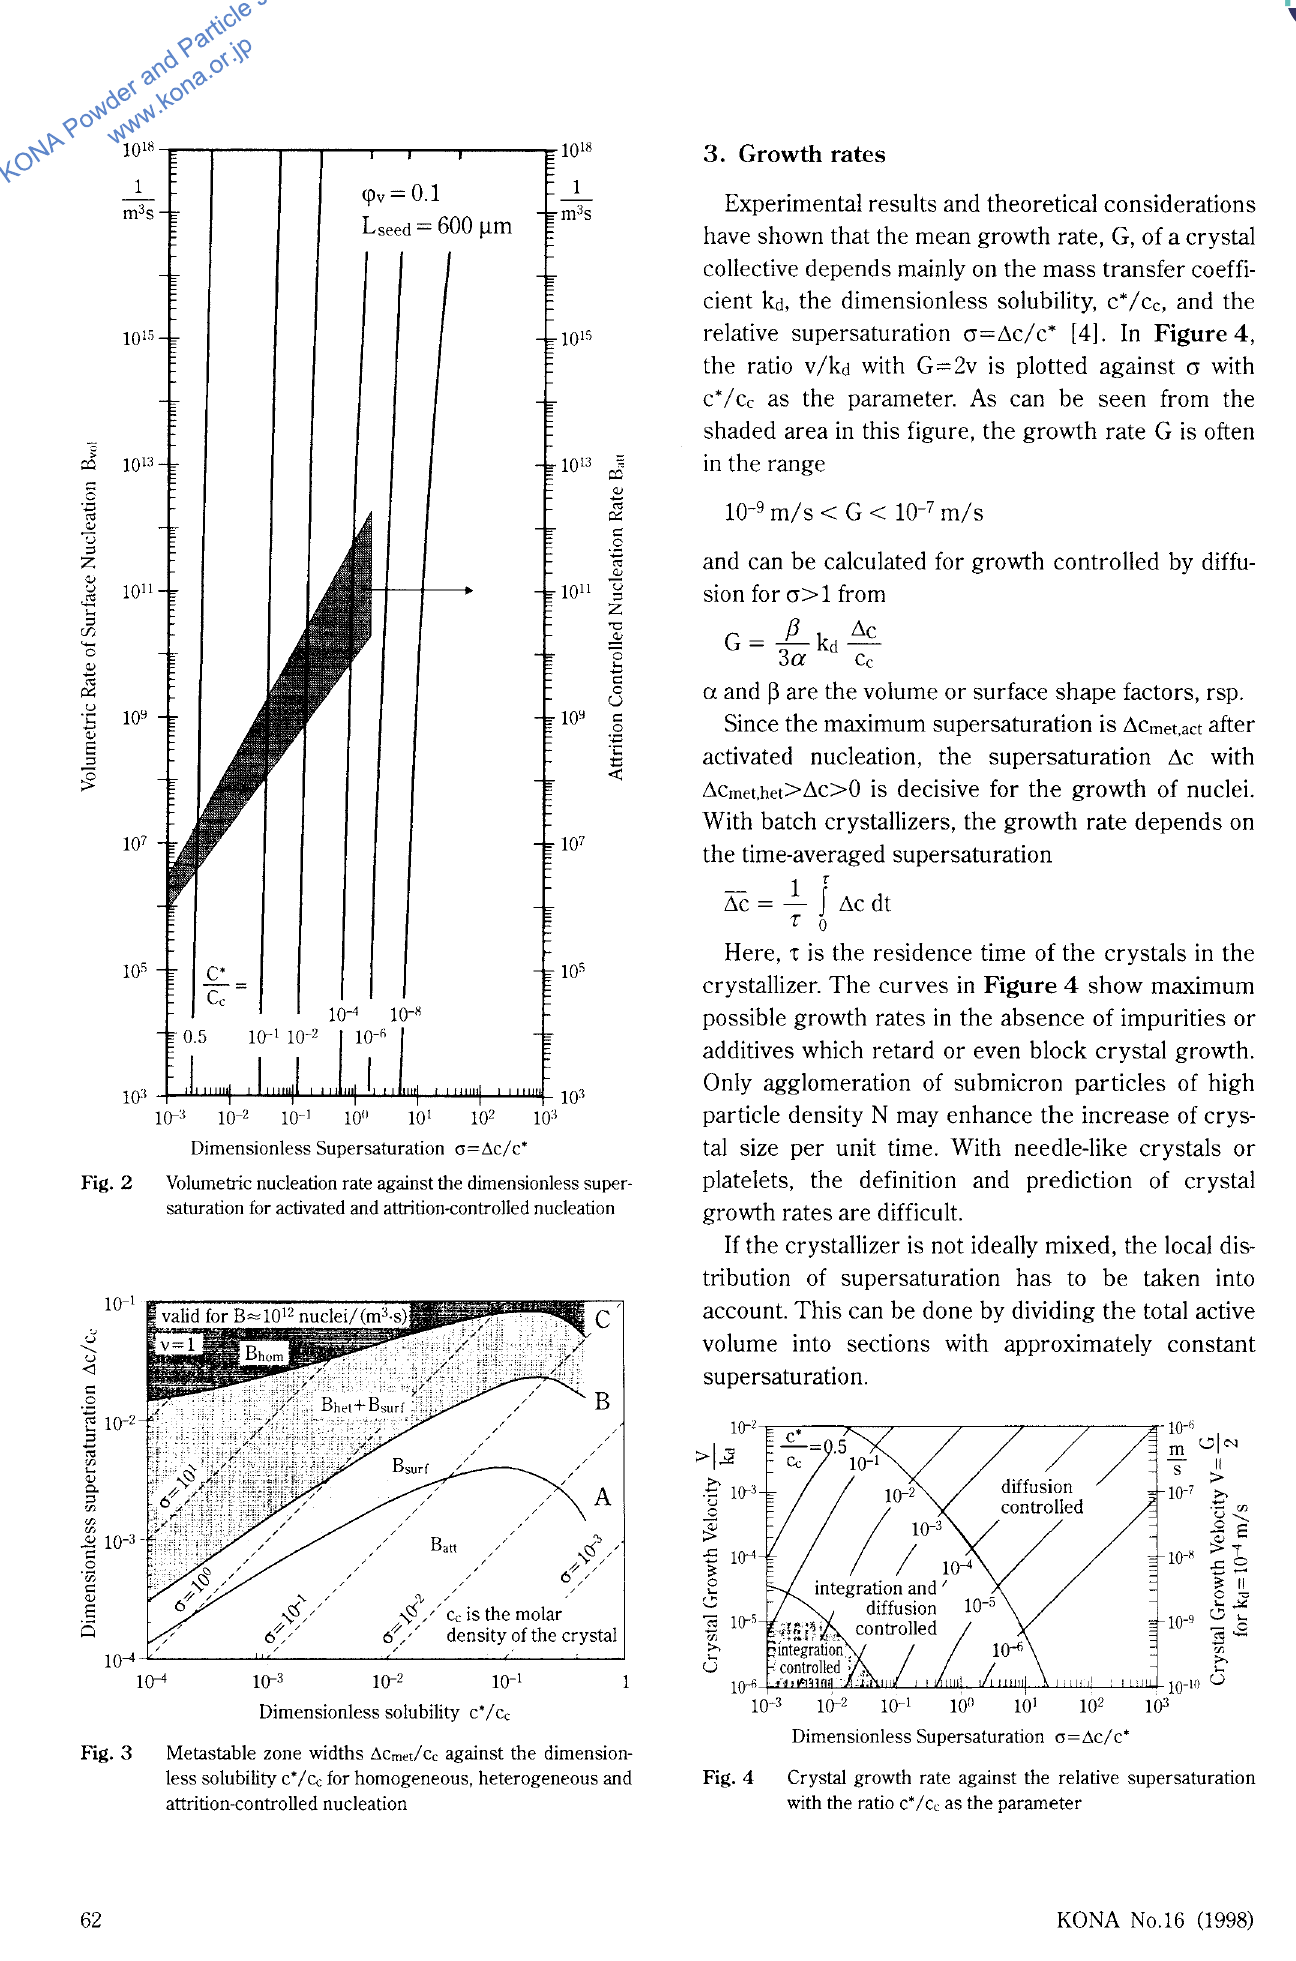
Crystal growth rate against the relative supersaturation with the ratio c' ICc as the